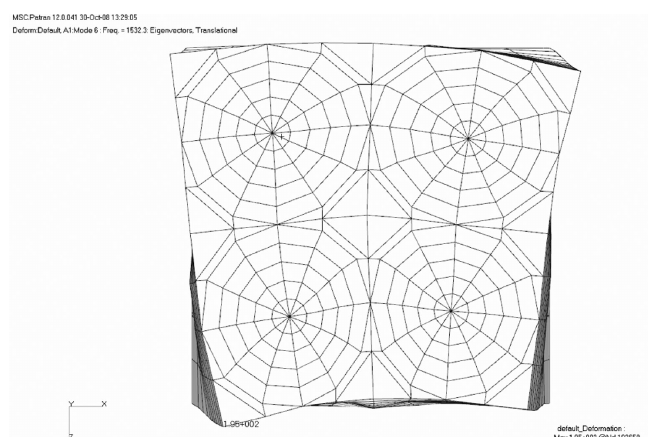
Fig. 19. 6th mode: 1532 Hz.